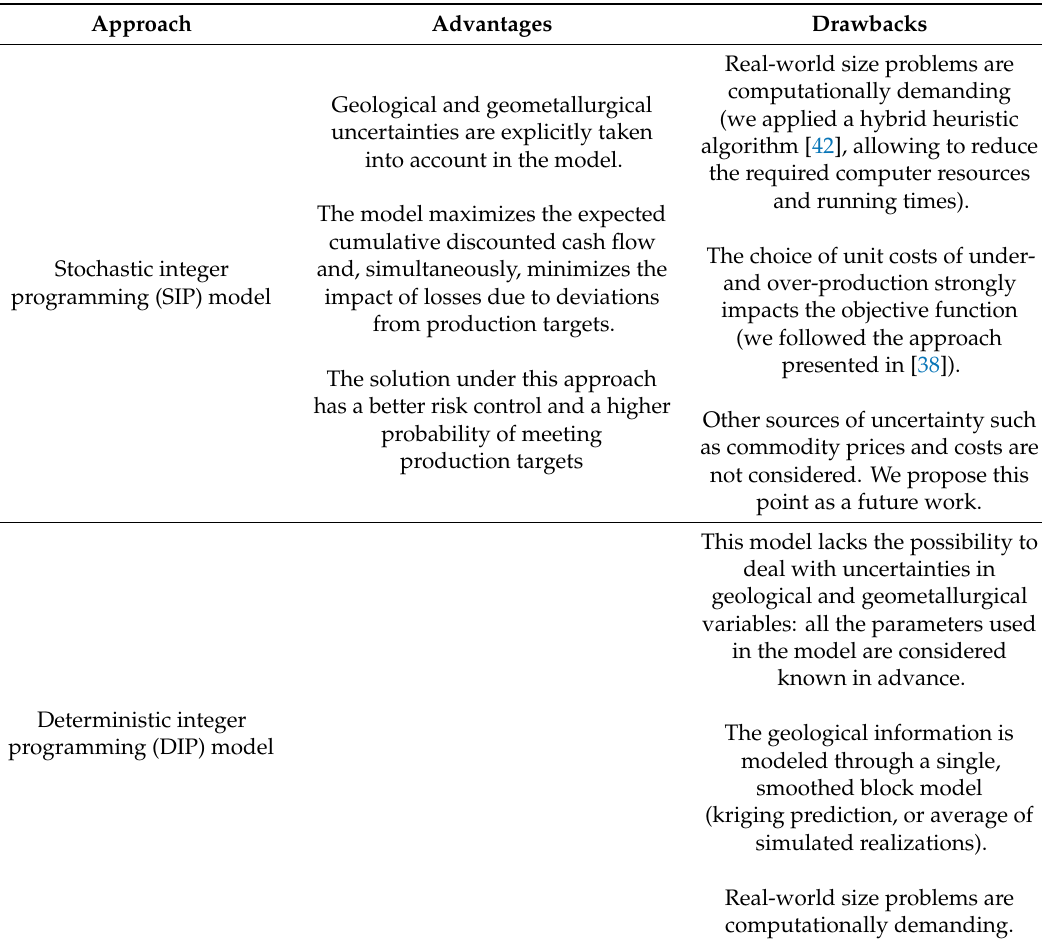
Figure 10. Extraction sequence (isometric view) along the planning horizon. Table 3. Advantages and drawbacks of the SIP and DIP approaches.